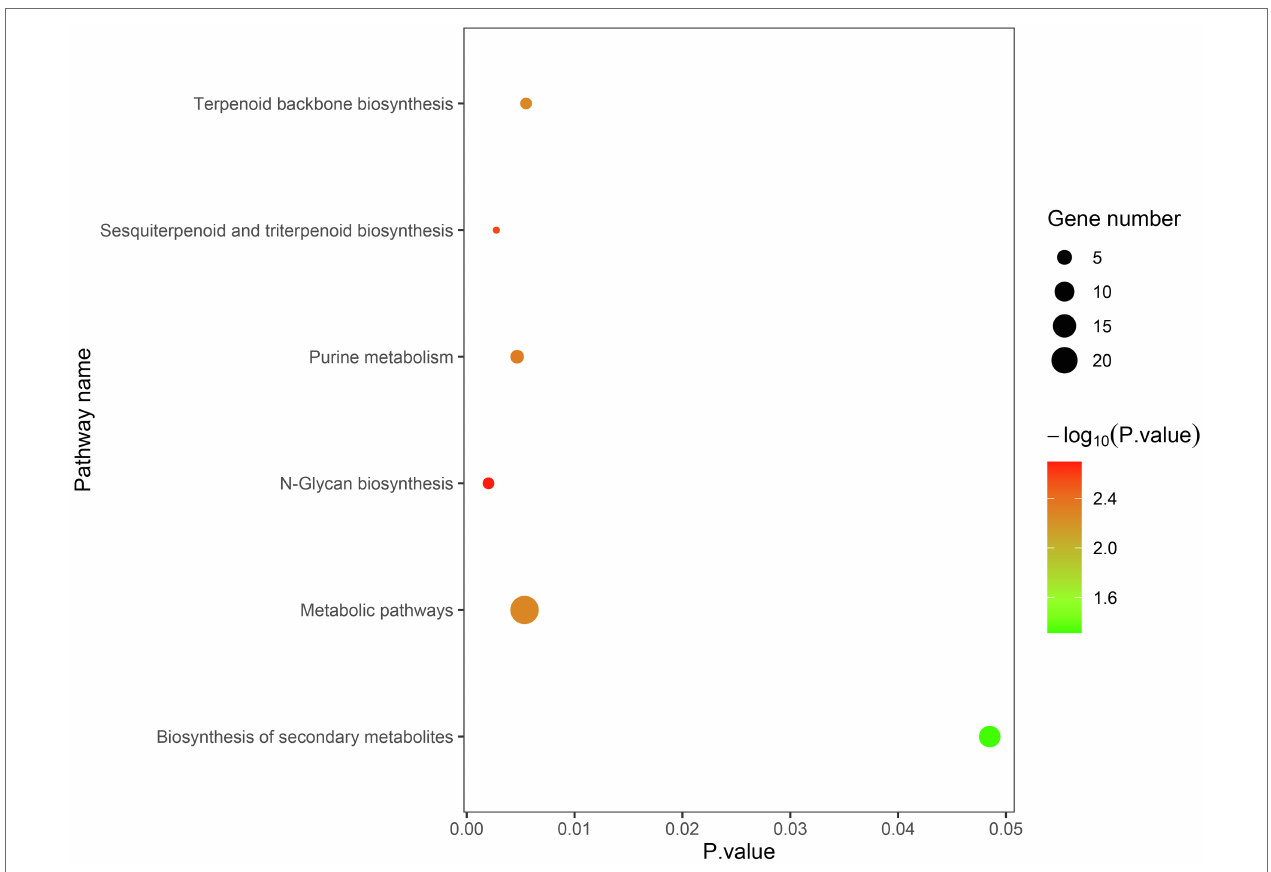
FIGURE 6 | Analysis of KEGG pathway based on candidate genes.